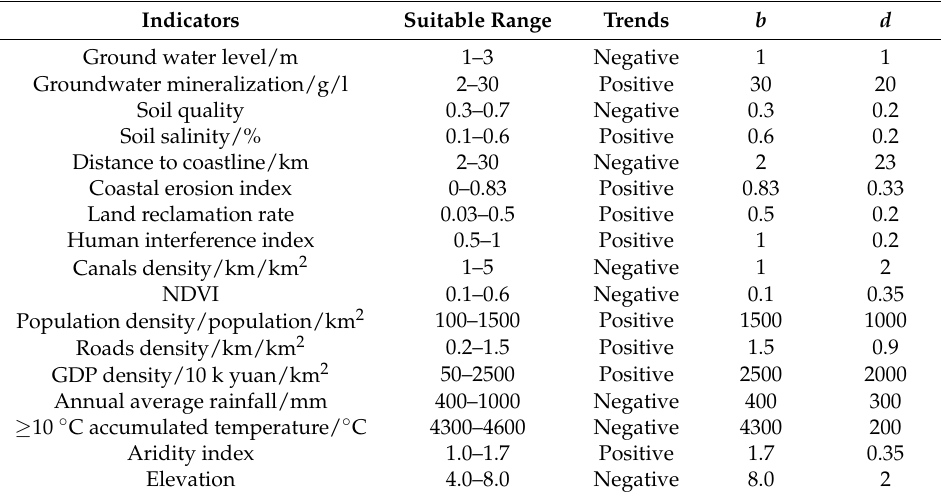
Table 2. Parameter values in the fuzzy membership